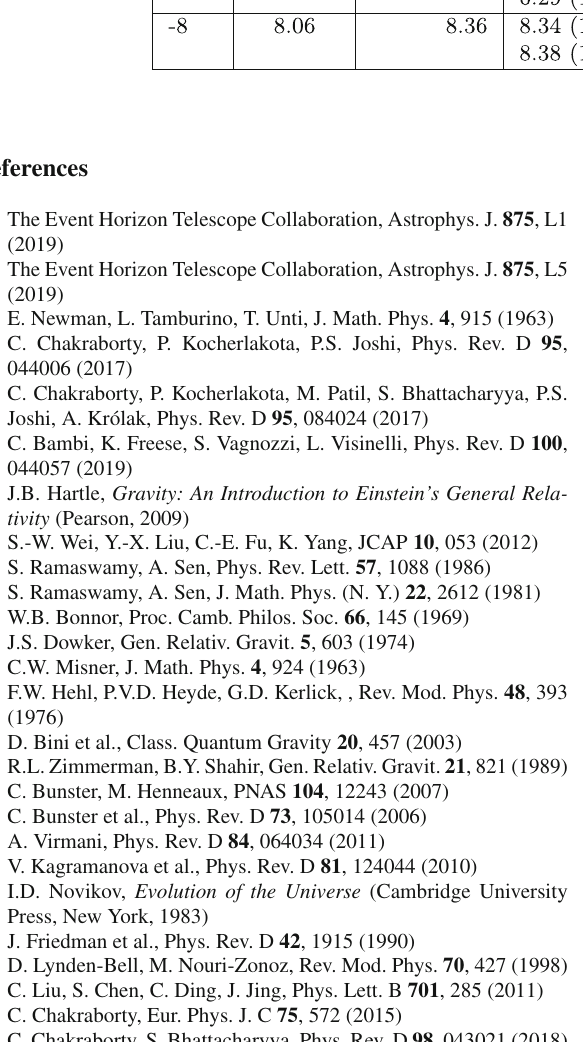
(cid:7) 1 + n 2 ∗ , (cid:7) 1 + n 2 ∗ for